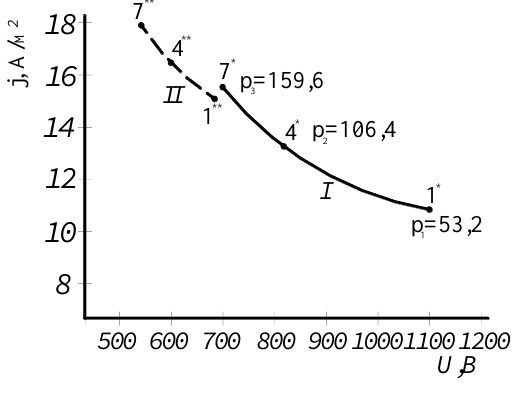
Fig. 4. Current-voltage characteristics of the BATR process at autonomous (interdependent) saturation modes (I and II are different forms of